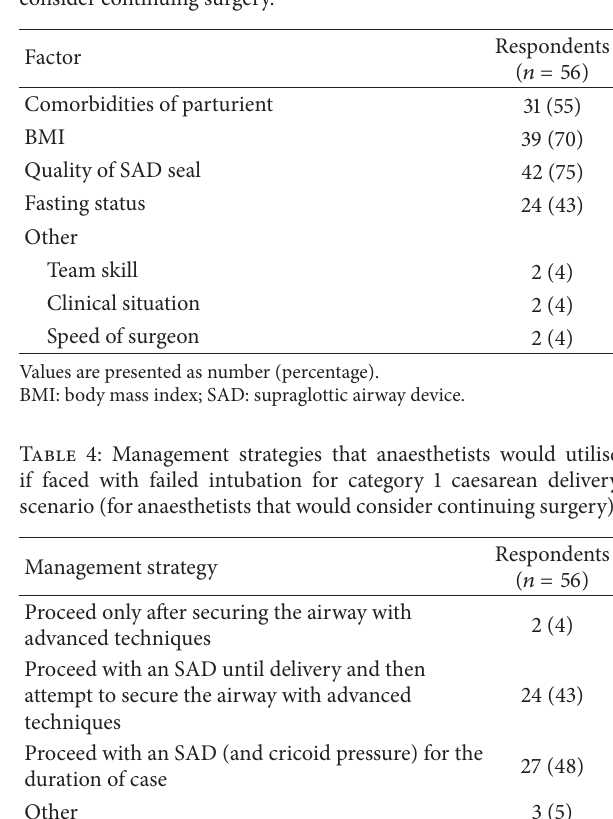
Table 5: Management strategies consultants would advise trainees faced with a failed intubation for category 1 caesarean delivery, now with a supraglottic airway device in